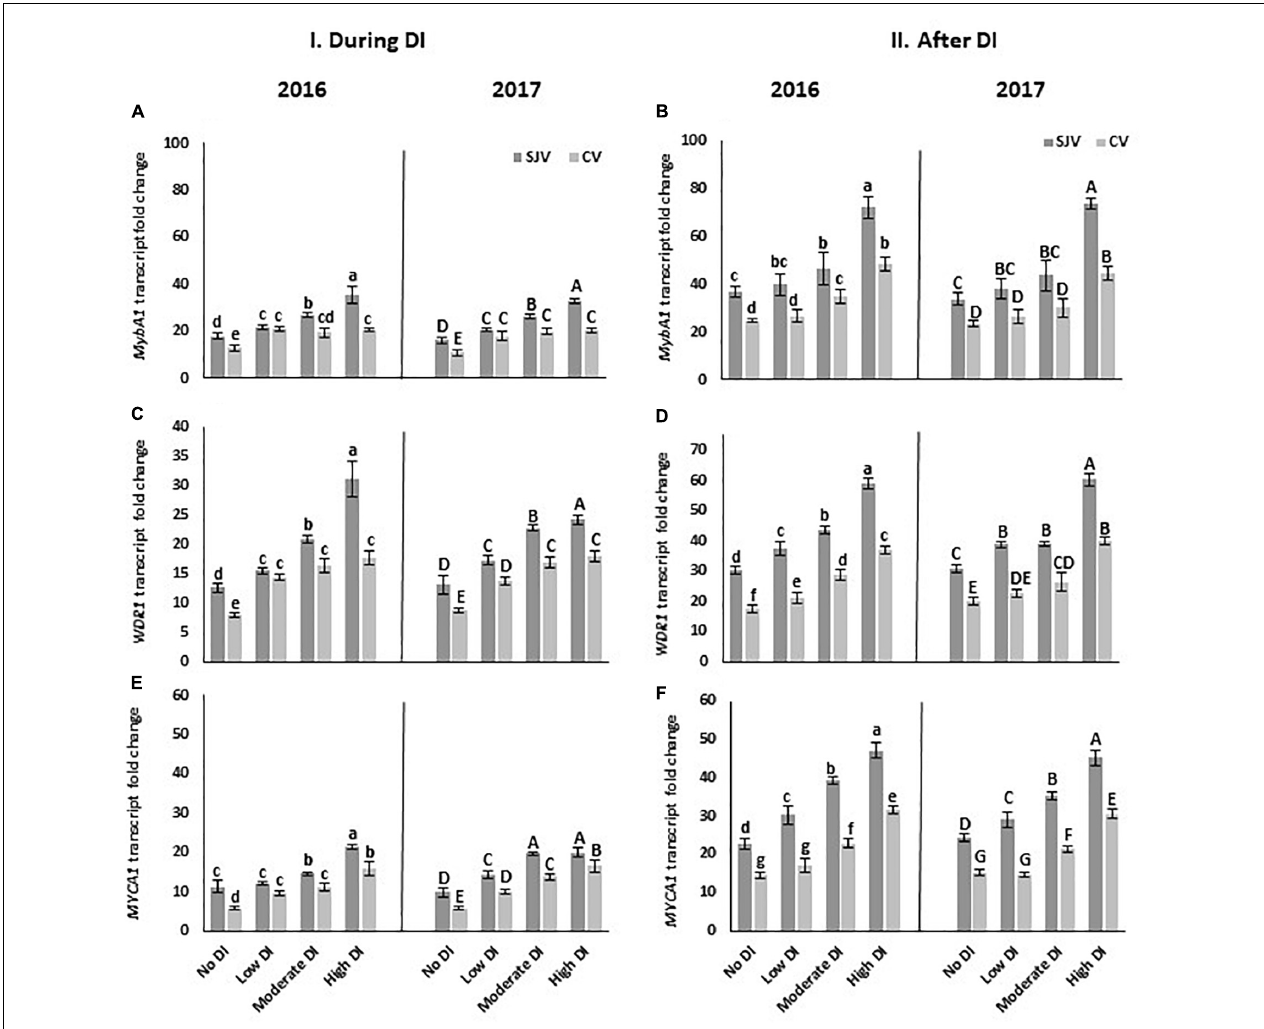
FIGURE 6 | Expression of transcription factors involved in anthocyanin biosynthesis pathway in Scarlet Royal berry skin as affected by deficit irrigation (DI) treatments in 2016 and 2017, in San Joaquin (SJV) and Coachella (CV) Valleys. Transcription factors are: MYBA1 (A,B) , WDR1 (C,D) , and MYCA1 (E,F) . Gene expression was calculated during deficit treatment (I. During DI) and after re-irrigating vines with the original schedule (II. After DI). The error bars represent the standard deviation. Different letters on bars indicate significant differences among treatments and locations at p < 0.05 according to the Tukey HSD test within the same season. Different lower-case letters indicate a significant difference among treatments and locations in 2016 while capital letters are used for